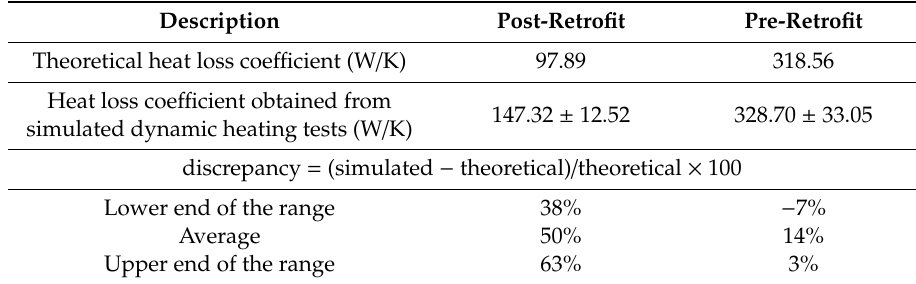
Table 10. Comparison of theoretical heat loss coe ffi cients and those measured with simulated dynamic heating